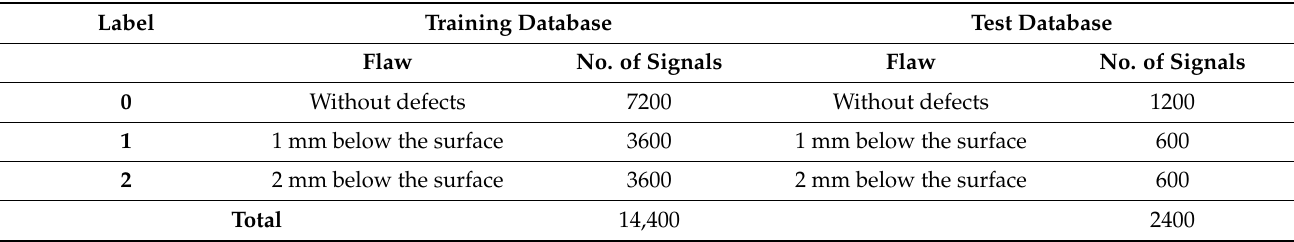
Table 2. Augmented